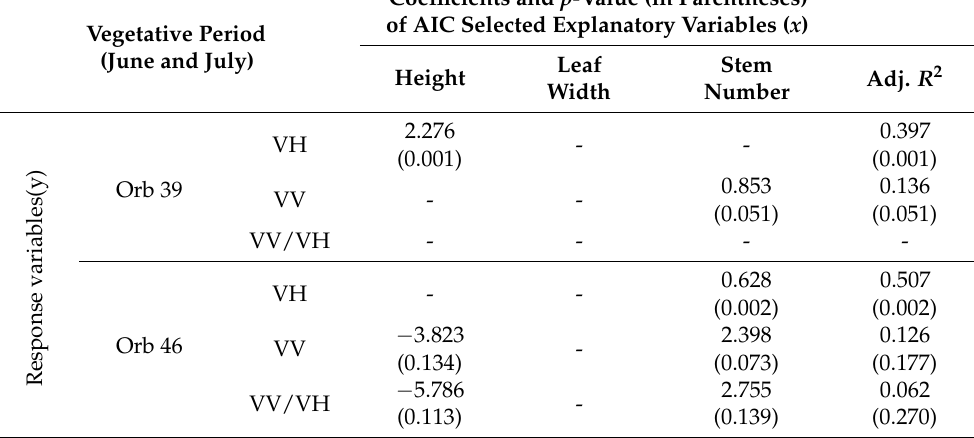
Table 2. Results of the multivariate linear regression analysis. Selected variables are shown with coefficients and p -values in parenthesis, a hyphen “-” indicates that the variable is not selected by the AIC method. The overall accuracy of the selected model was evaluated with Adj. R 2 and p -value are shown in parenthesis. Data in orb 39 (ascending) and 46 (descending) were analyzed separately for the vegetative period (June and July). Leaf and panicle water contents were not observed during the vegetative period.